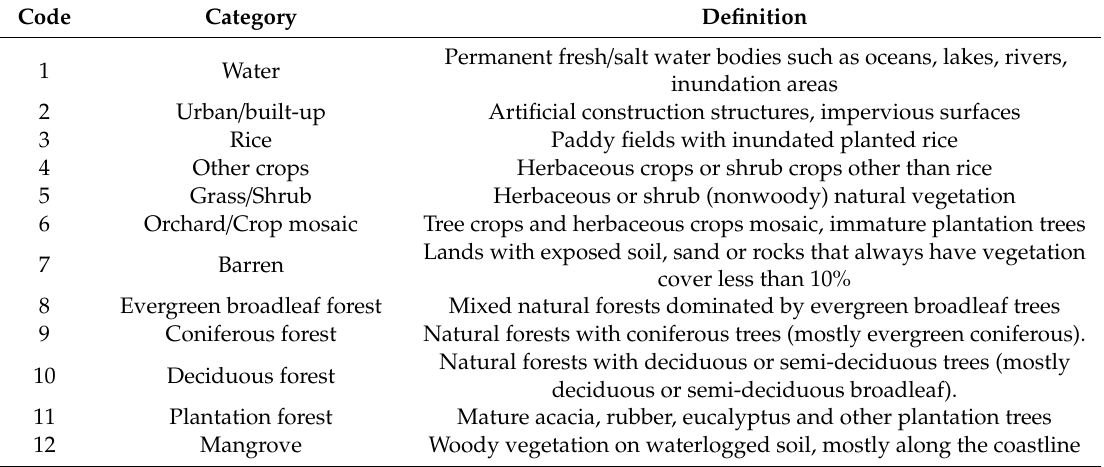
Table 3. Description of the land cover categories of the Vietnam LULC